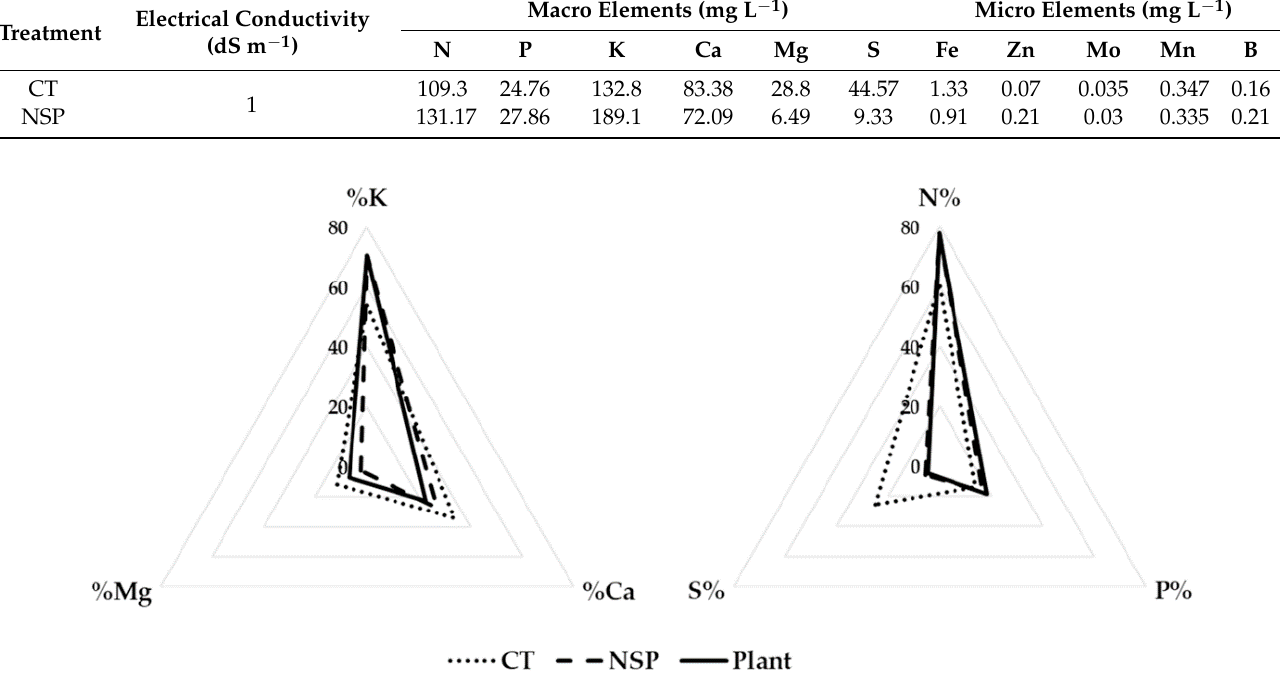
Figure 1. The ratio of the cations (K, Mg, Ca) and anions (N, S, P) of red perilla plant, greenhouse nutrient solution (CT), and the newly-developed nutrient solution for red perilla (NSP).